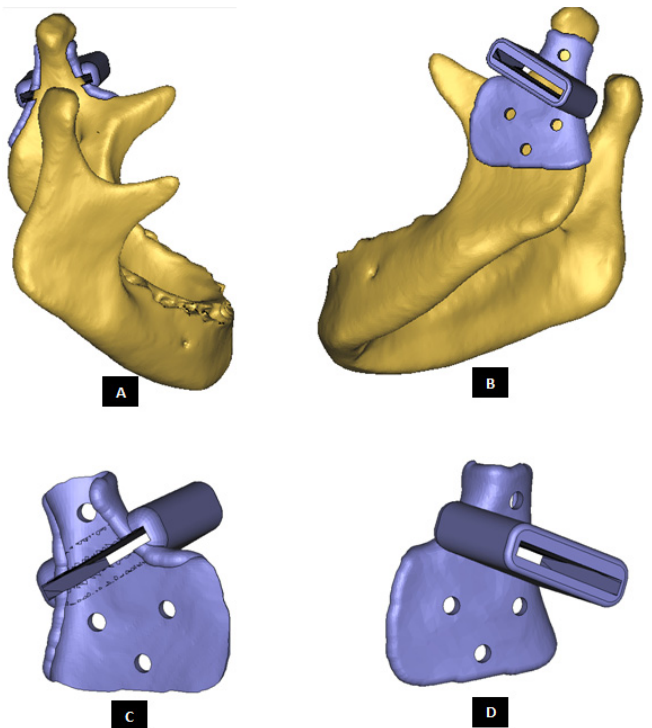
Figure 3. Custom-designed surgical guide for condylectomy (i.e., removal of damaged part of the condylar bone). ( A , B ) Show the medial and lateral view, respectively, of surgical guide placed at the location on mandible where osteotomy is to be performed. ( C , D ) Show medial and lateral–anterior view, respectively, of the surgical guide alone. The visuals demonstrate that custom-design of the device enables it to accurately adapt to the native bone. This methodology allows the designer to control size and shape of the device, and location of its fixation screws as prescribed by the surgeon.